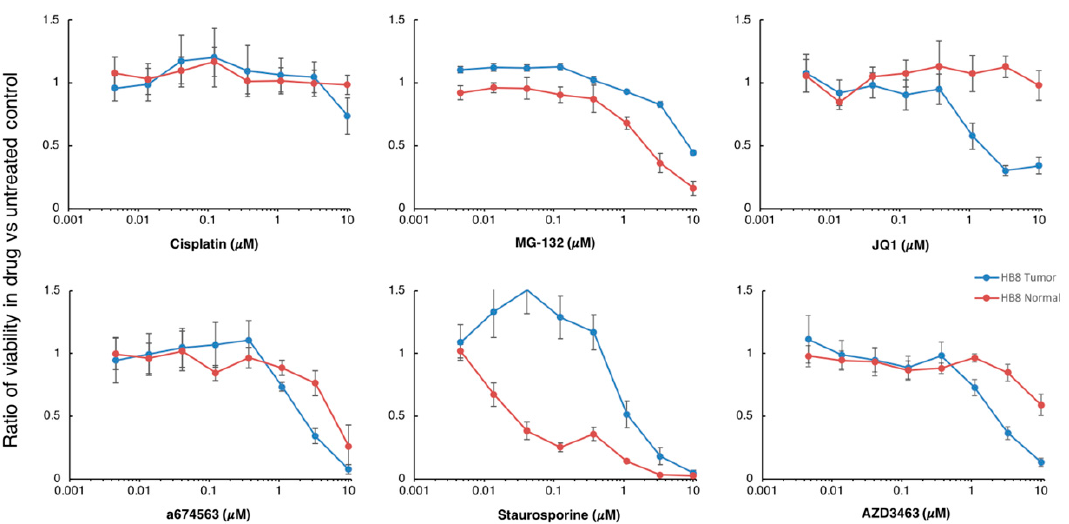
Figure 6. Organoid drug screen results for 6 selected compounds. Normal and tumor organoids were tested simultaneously for multiple concentrations between 1 nM and 10 µM. Plots shown are the mean of three biologic replicates each performed in triplicate at each dilution. Error bars represent standard error of all replicates. Cisplatin which is commonly used to treat hepatoblastoma showed no differential effect on tumor organoids compared to normal. JQ1 demonstrated increased killing of tumor organoids compared to normal organoids and may be candidate for novel therapy in aggressive